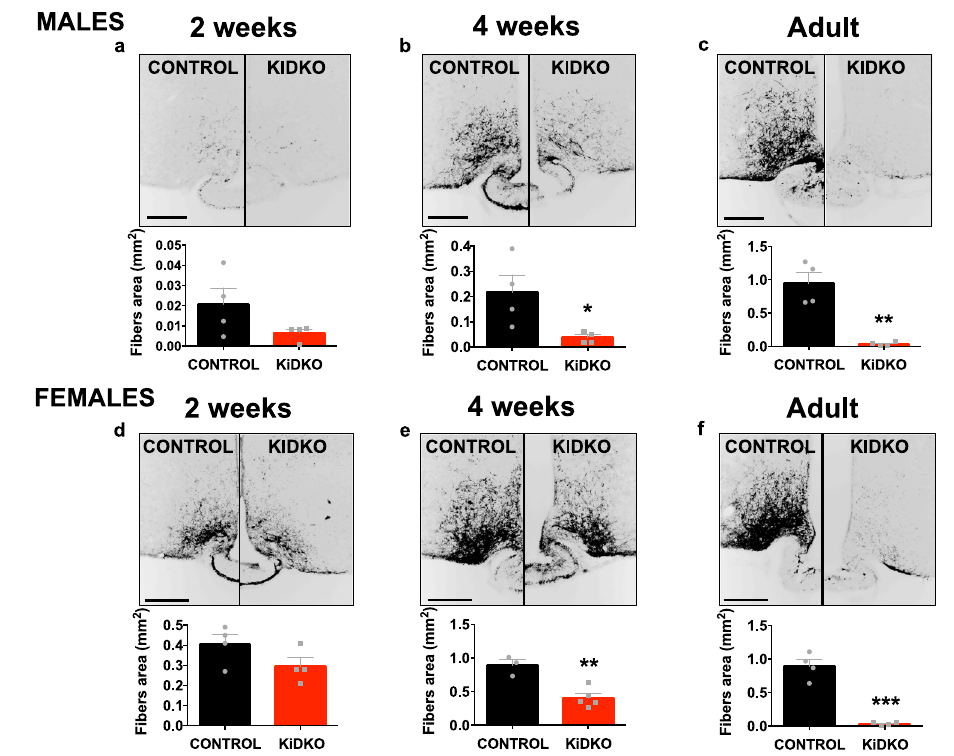
Fig. 5 | Hypothalamic NKB immunoreactivity in KiDKO mice along postnatal maturation. Detection of NKB content in situ was conducted using immunohis- tochemistry, which allowed labeling of fi bers with NKB immunoreactivity (IR). Representative images and quantitative data on NKB-IR fi bers (area) in the ARC of male ( a – c ) and female ( d – f ) KiDKO mice, and their corresponding controls, are presented. Data were collected at three postnatal ages: 2 weeks (corresponding to